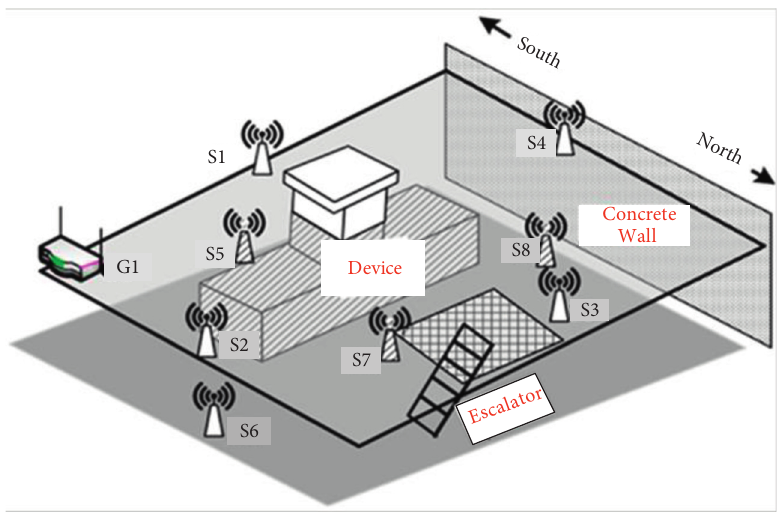
Figure 17: Simulation bench test of wireless sensor network engine room environment.